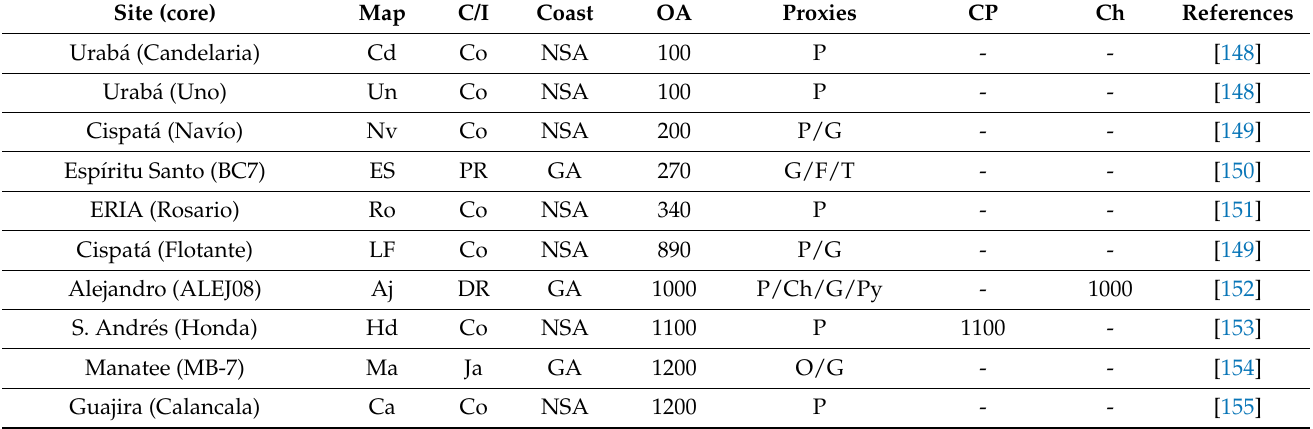
Table 3. Caribbean mangrove records considered in this study. All records were dated by 14 C, except for the youngest sections (dated by 210 Pb) and the Pleistocene sections, which were dated by isotopic correlation (MD03-2622) and electron spin resonance (ESR) (P. Morant). Multiproxy studies always contain pollen records. Oldest ages (OA) of records, the first records of cultivated plants (CP), and the onset of significant/continuous charcoal records (Ch) are in cal yr BP (* yr BP beyond the 14 C range), unless specifically stated. Dates have been taken from the original references and rounded to the nearest tenth. Coasts: CA, Central America; GA, Greater Antilles; LA, Lesser Antilles; NSA, northern South America. Country/island (C/I) codes are as in Figure 5 (SC, St. Croix). Proxies: A, archaeology (lithic/ceramic/shell/coral artifacts); Am, animal macroremains; Ch, charcoal; D, dinoflagellates; Dt, diatoms; F, foraminifers; G, geochemistry (organic matter, elemental analysis, stable isotopes); Mp, molecular phylogenetics and phylogeography; O, ostracods; P, pollen; Ph, phytoliths; Pm, plant macroremains; Py, physical properties (magnetic susceptibility, paleomagnetism, petrography/mineralogy); S, sedimentology/stratigraphy; St, starch; T,